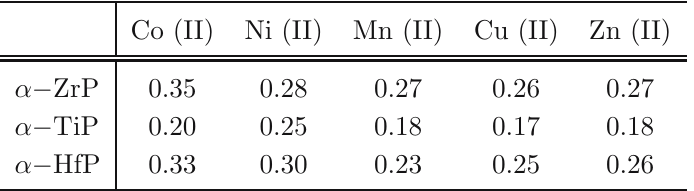
Fig. 2 The 001 projection of α -hafnium phosphate structure. Table 8 Ratio of relative intensity between peaks of 002 position of pristine phosphates and their transition metal containing